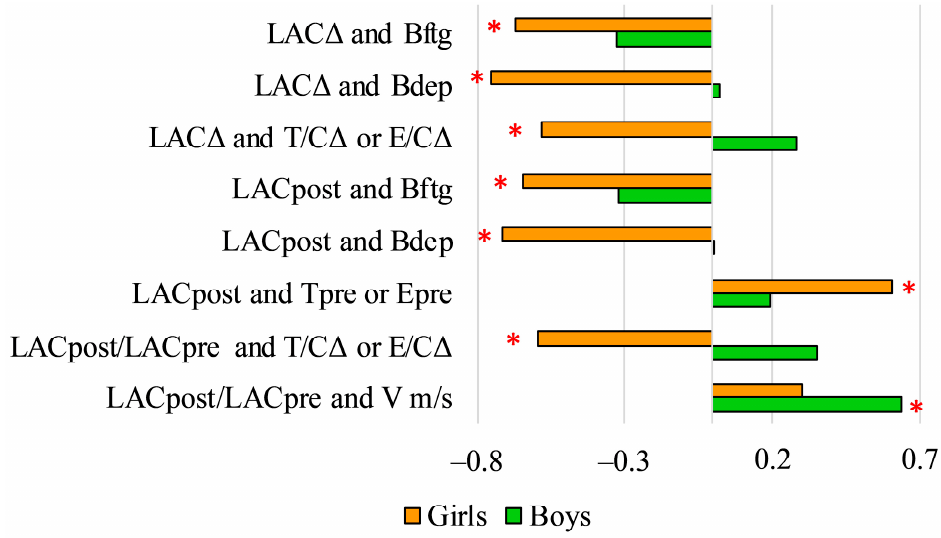
Figure 4. Pearson’s correlation coefficient (r) values of LAC variables and other psychological and physiological variables (* p < 0.05). LAC ∆ : difference of lactate levels before and after the field test; Bdep: score of depression on the BRUNEL scale; T/C ∆ : difference of testosterone-cortisol ratio before the field test and 30 min after the field test; E/C ∆ : difference of estradiol-cortisol ratio before the field test and 30 min after field test; Bftg: score of fatigue on the BRUNEL scale; LACpost: lactate levels after the field test; Tpre: testosterone levels before the field test; Epre: estradiol levels before the field test; LACpost/LACpre: ratio of lactate levels before and after the field test; V m/s: average speed of the swimmers’ during the 200 m maximal freestyle swimming.